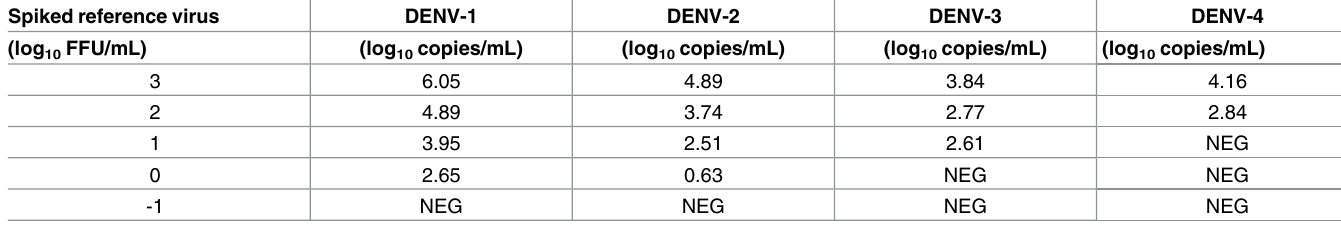
Table 2. Analytical sensitivity test for the LightMix dengue virus EC qRT-PCR